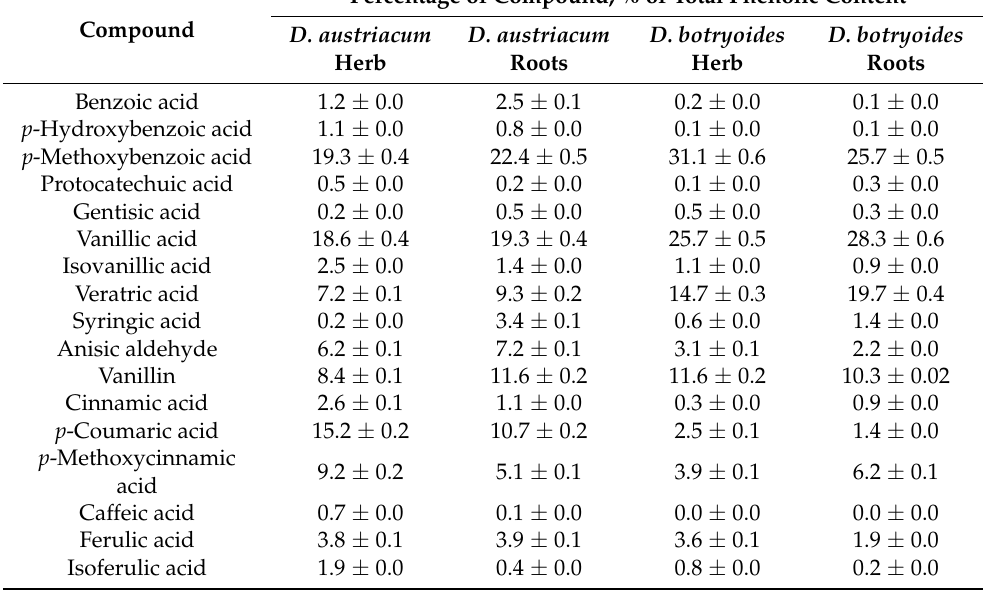
Table 3. Phenolic compounds released after alkaline hydrolysis of water-soluble polysaccharides of herbs and roots of D. austriacum and D. botryoides